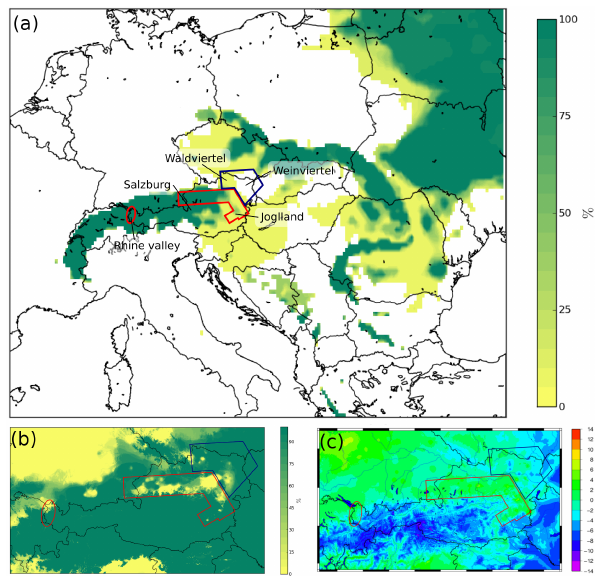
Figure 3. Probability for temperature below 0 ◦ C as forecast by LAEF (a) and En-INCA (b) for 31 December 2012, 05:00UTC, and the INCA temperature analysis for the corresponding time period (c) . Marked regions are discussed in more detail in the